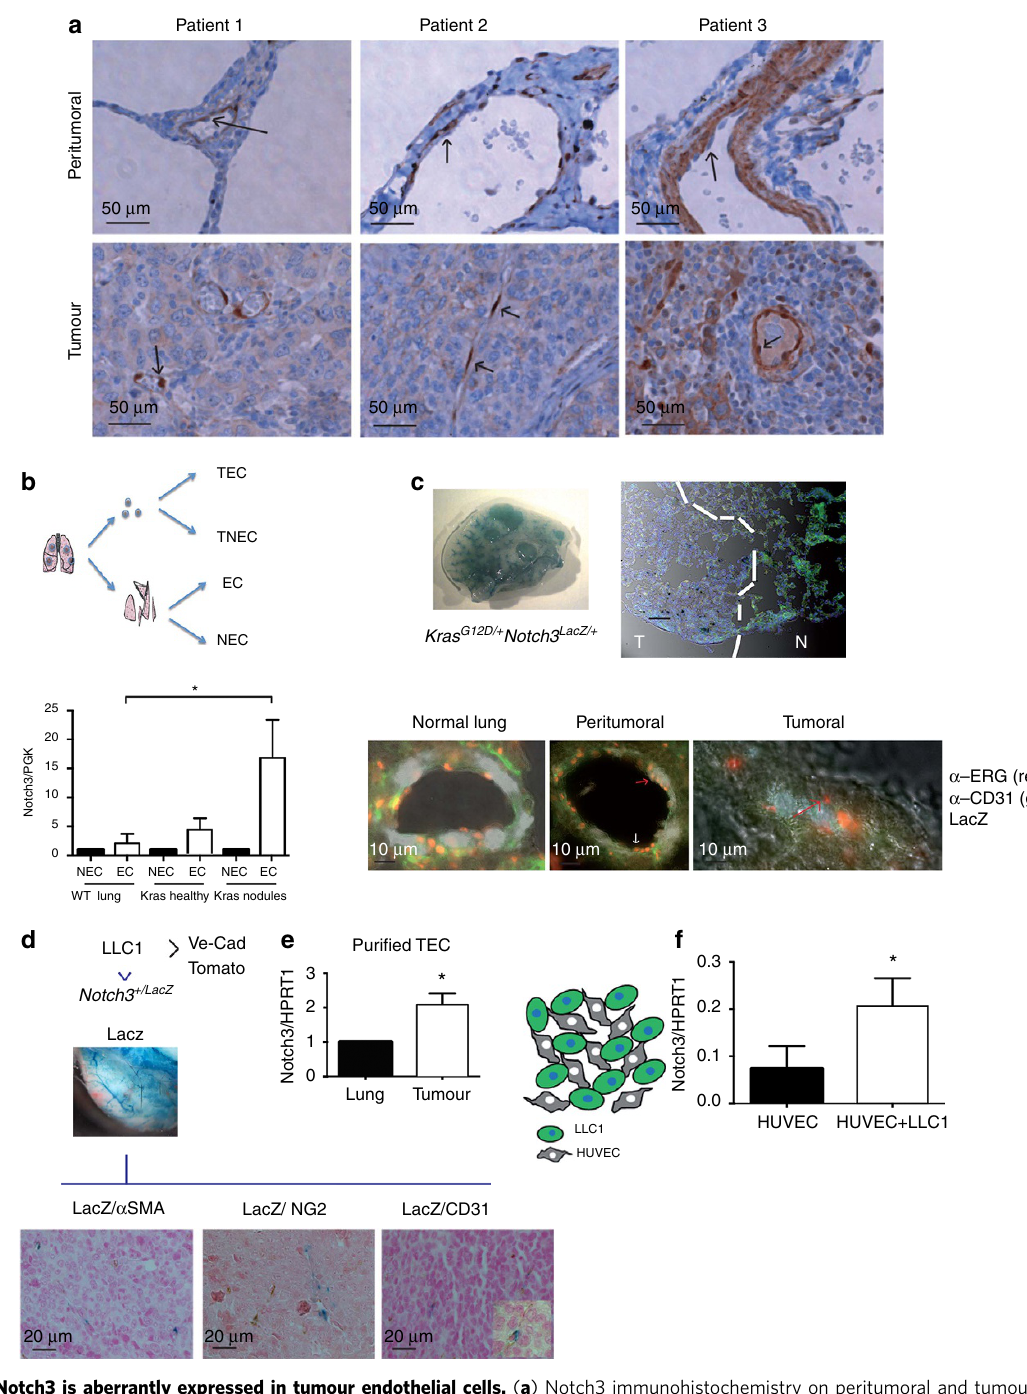
Figure 1 | Notch3 is aberrantly expressed in tumour endothelial cells. ( a ) Notch3 immunohistochemistry on peritumoral and tumour part of three sections from non-small cell lung cancers patients. ( b ) Quantitative RT-PCR was performed to measure Notch3 mRNA expression in endothelial cell enriched fraction (EC, CD31-expressing purified cell population) or non endothelial cell (NEC) purified from lung dissected from wild-type mice, the healthy part of tumour-bearing lung dissected from Kras mice or from the nodules dissected from the lung of Kras mice ( n ¼ 6 WT lungs, n ¼ 5 Kras lungs, mean ± s.e.m., ordinary one-way ANOVA, multiple comparisons). ( c , d ) b -galactosidase staining was performed on lungs or LLC1 tumour whole mount from Kras G12D/ þ ( c ) or WT mice ( d ) mice before inclusion in paraffin and immunohistochemistry staining for ERG, CD31, SMA, NG2 as indicated. ( e ) Quantitative RT–PCR was performed to measure Notch3 mRNA expression in endothelial cell FACS-sorted from lung or tumour dissected from Cdh5:Cre ERT2 xTomato (Ve-Cad Tomato) mice ( n ¼ 3 tumours, mean ± s.e.m., unpaired t -test). ( f ) HUVEC cells were co-cultured for 48h with LLC1 cells stably expressing GFP before being FACS sorted. DAPI (alive cells) GFP negative (HUVEC) cells were used to prepare mRNA and Notch3 expression was measured by quantitative RT–PCR ( n ¼ 3 independent experiments, paired ratio t